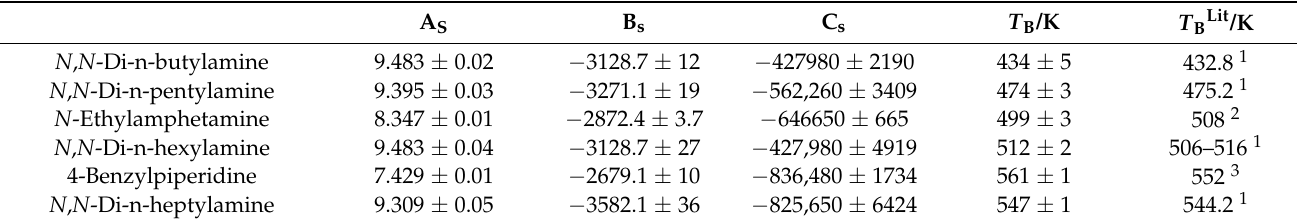
Table 7. Coefficients of the second order polynomial, Equation (8); p o = 101,325 Pa.